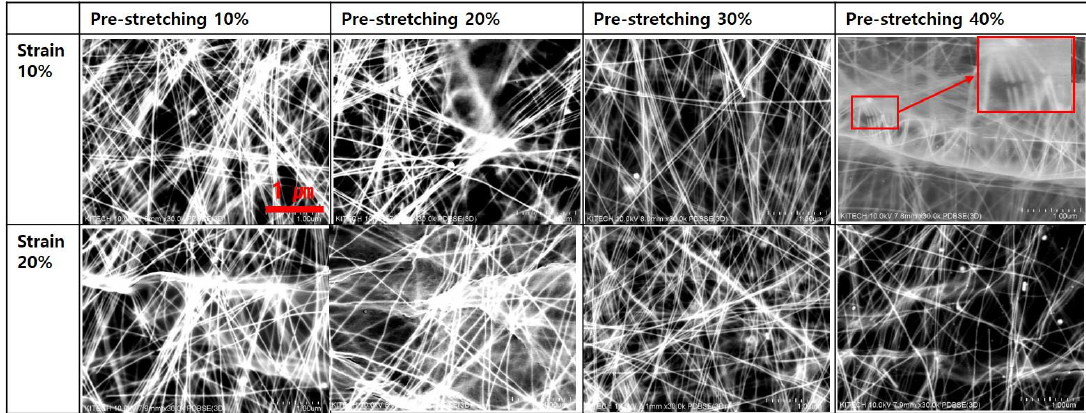
Figure 7. Plan view FESEM images of Ag NWs electrodes with pre-stretching and applying 10 and 20% strain.